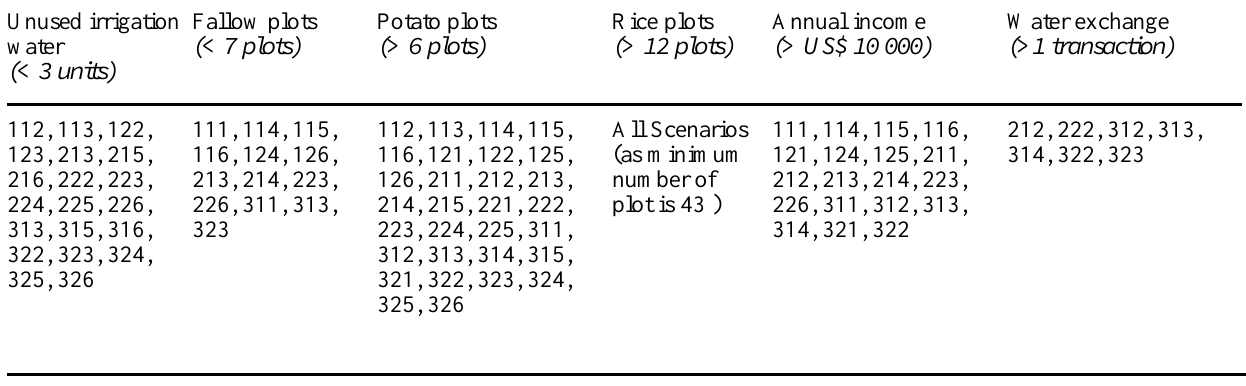
Table 3. Classification of scenarios based on thresholds of six criteria and conditions. First digit represents social network (1, 2, 3); second digit represents rainfall (1 and 2); and third digit represents protocol (1 to